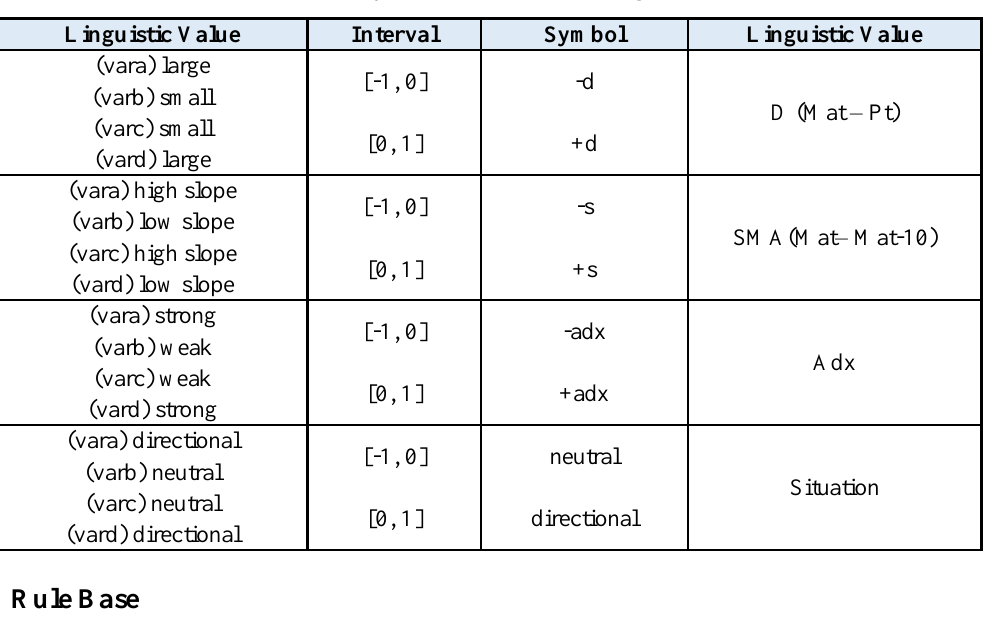
Table 4. A Summary of the Conditions of Linguistic